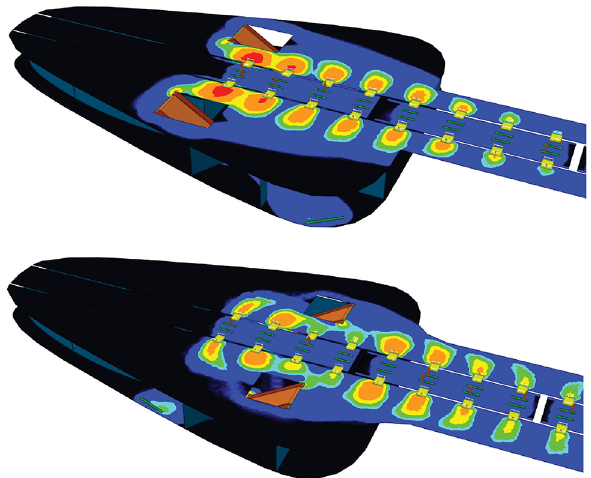
Fig. 2 Results of crowd simulation with agent-based modeling (top: entrances toward the end of subway platform create hot spots; bottom: entrances toward the middle of the subway platform create a better distribution of passengers and fewer hot spots). By Jordan